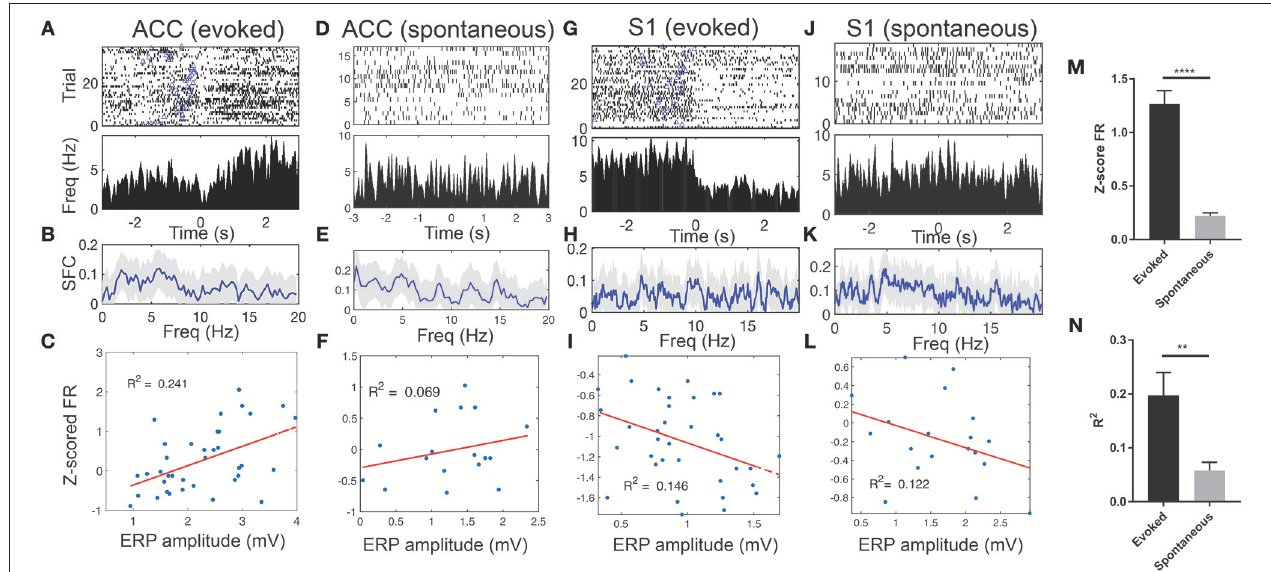
FIGURE 5 | Spike phase locking of one representative ACC units and one representative S1 unit simultaneously recorded during evoked pain and spontaneous pain-like episodes (rat #15). (A) Spike raster and ERP-triggered peri-stimulus time histogram (PSTH). Bin size: 10 ms. Time 0 represents the peak of ERP. Blue triangle at each row indicates the onset of laser stimulation at each trial. Note that these two units decreased their firing rates around time 0. (B) Spike-field coherence (SFC). Shaded areas denote the jackknife error bar. Note that there was a peak in the theta frequency band. (C) Correlation between the Z-scored firing rate (FR) of pain-modulated units and the ERP peak-to-trough amplitude ( p 0.002, Pearson’s correlation). (D–F) Similar to A–C , the same ACC unit during spontaneous = pain-like episodes. (G–L) Similar to A–F , except for the S1 unit. In panels F,I,L , the P -values of Pearson’s correlation are 0.307, 0.023, and 0.142, respectively. (M) Population statistics of Z-scored mean FR (in absolute value) of pain-modulated ACC and S1 units ( n 32) during evoked pain and spontaneous pain-like episodes. = (N) Population statistics of R 2 values (for regressing the Z-scored FR and the ERP amplitude). ∗∗ p < 0.01, ∗∗∗∗ p < 0.0001, unpaired t